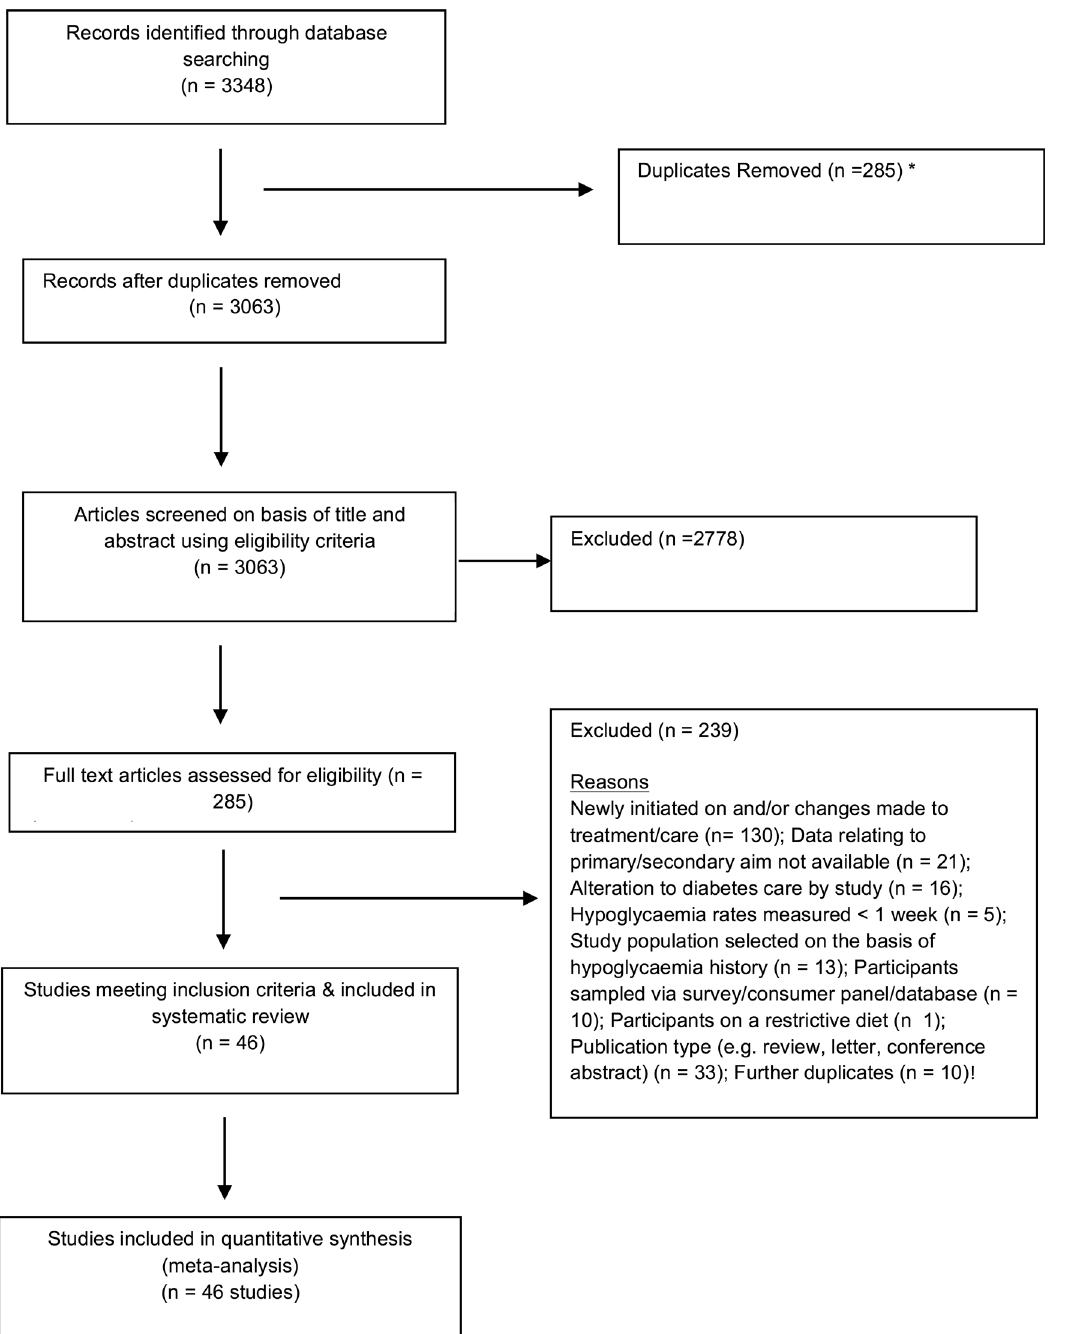
Fig 1. Flowchart of selection of studies from search to final